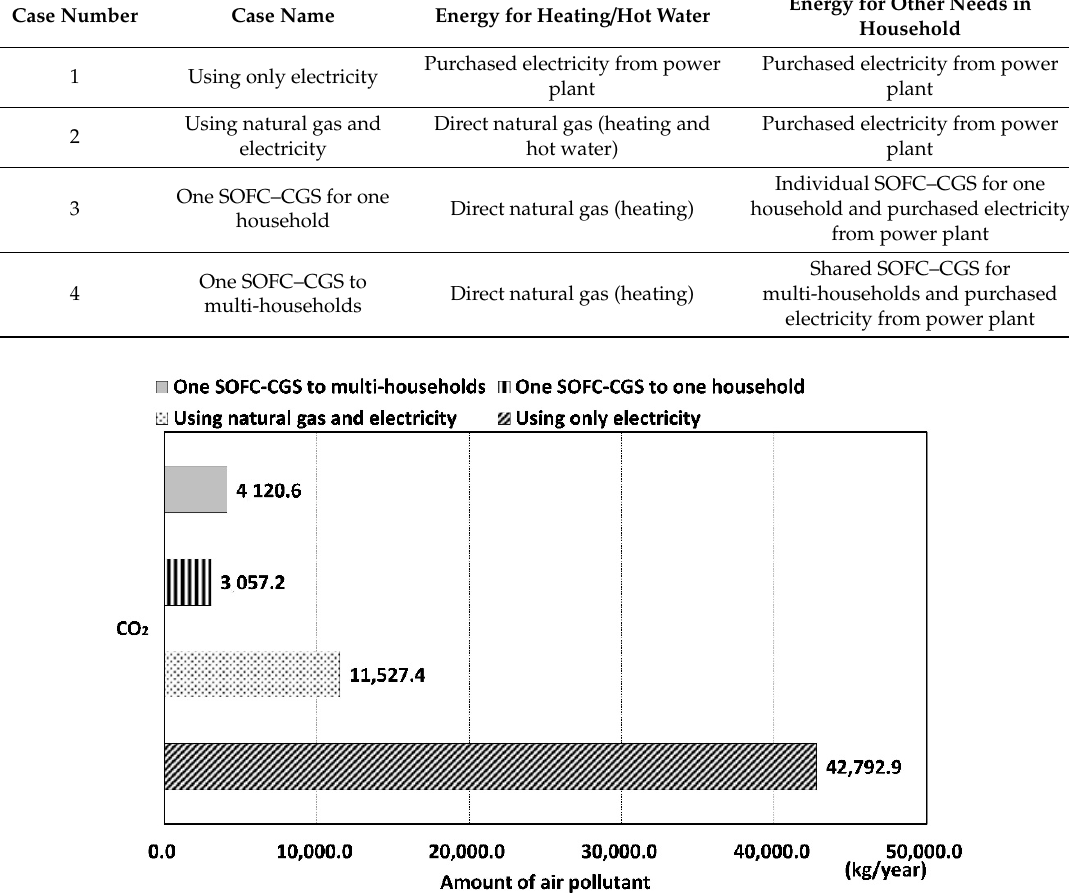
Table 8. Explanation of cases for environmental analysis.